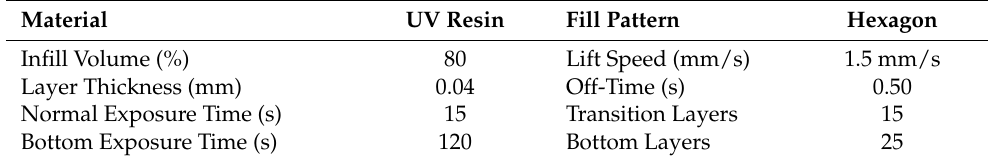
Table 2. Printing parameters of material used for strain sensor fabrication in the SLA 3D printer. Material UV Resin Fill Pattern Hexagon Infill Volume (%) 80 Lift Speed (mm/s) 1.5 mm/s Layer Thickness (mm) 0.04 Off-Time (s) 0.50 Normal Exposure Time (s) 15 Transition Layers 15 Bottom Exposure Time (s) 120 Bottom Layers